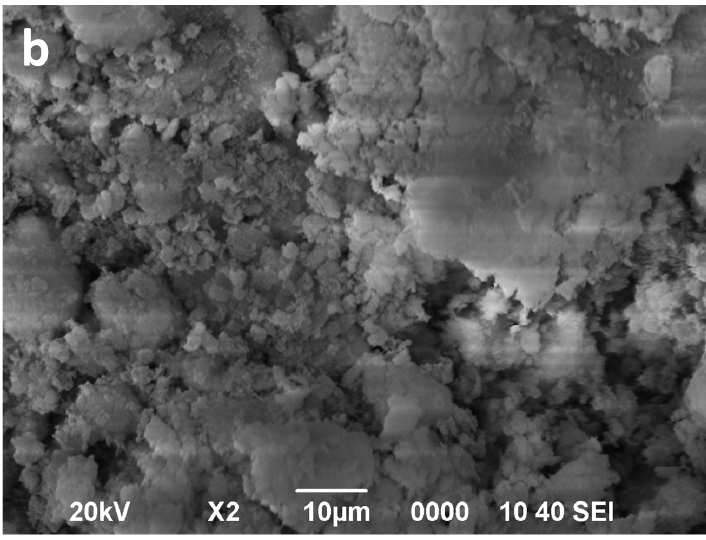
Figure 7. SEM images of Bs ( a ) and Bs after 16 min of microwave-assisted acid treatment ( b ).